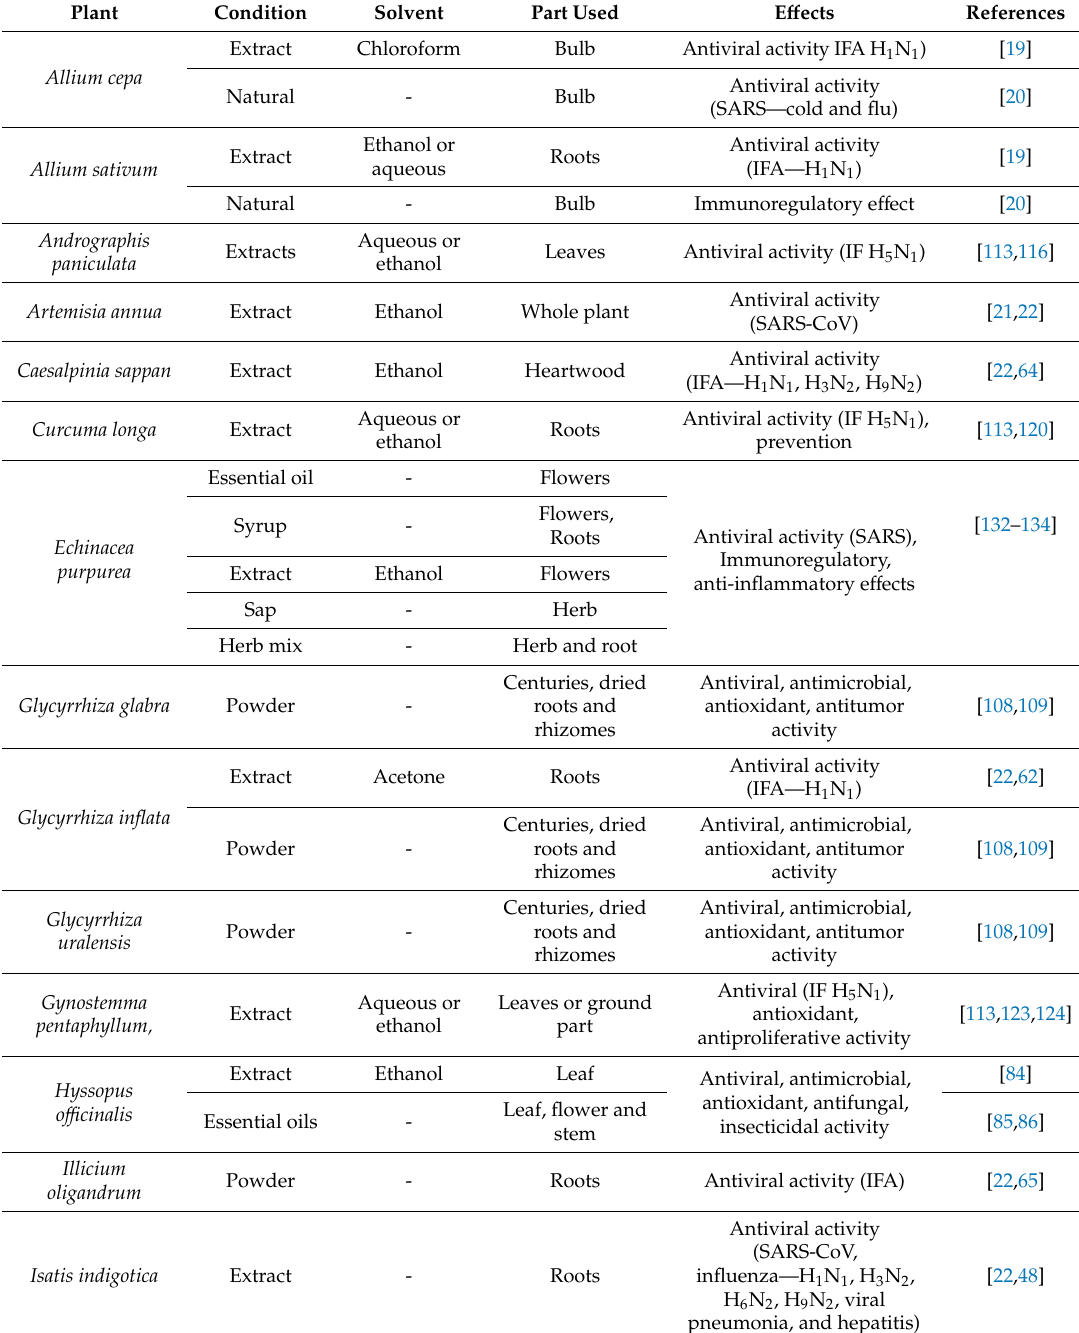
Table 2. E ff ects of medicinal